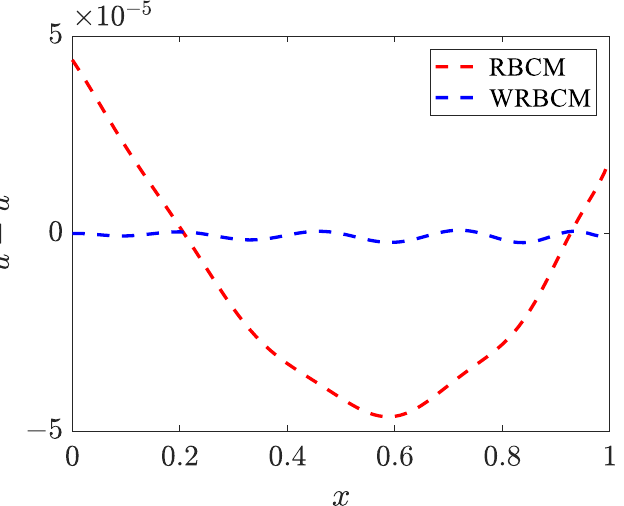
Figure 4. Solution comparison between RBCM and WRBCM for the 1D constant parameter identification problem.